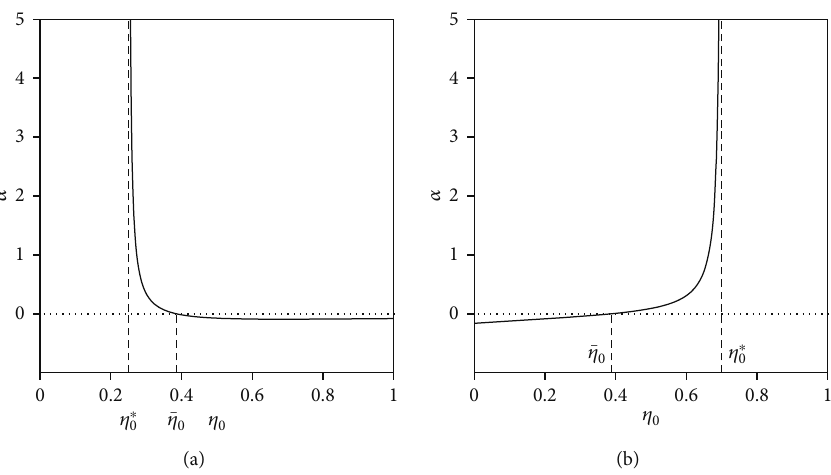
Figure 2: η - α relation of a standing pulse of the RD system (1). (a) s 0